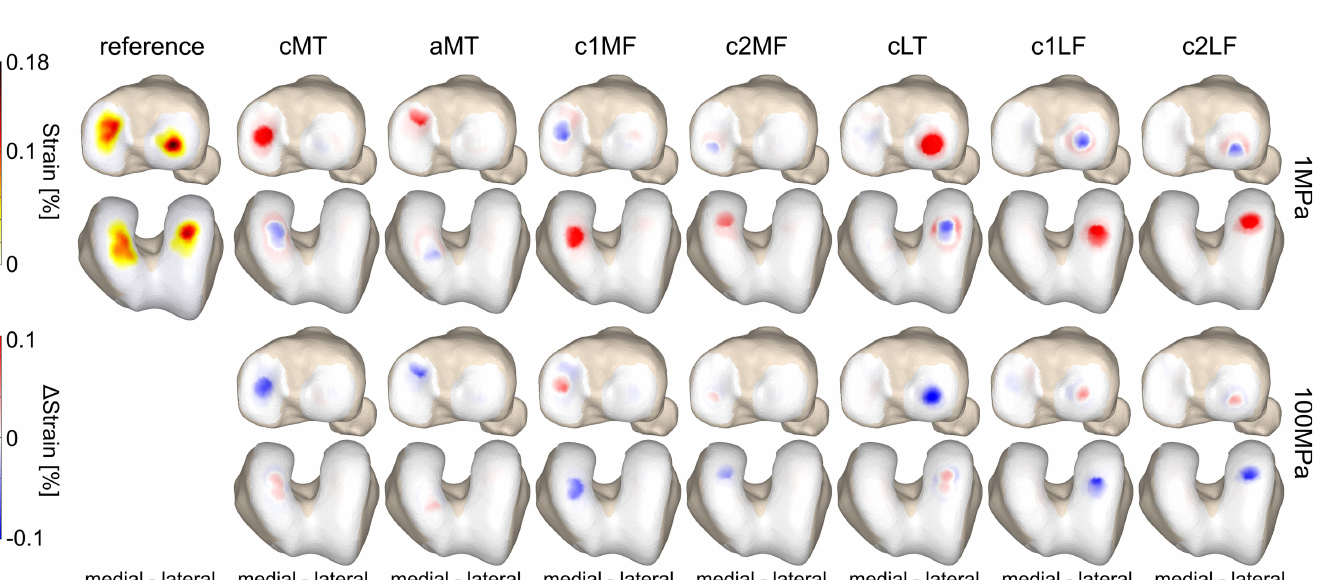
PLOS ONE | https://doi.org/10.1371/journal.pone.0205842 October 16,